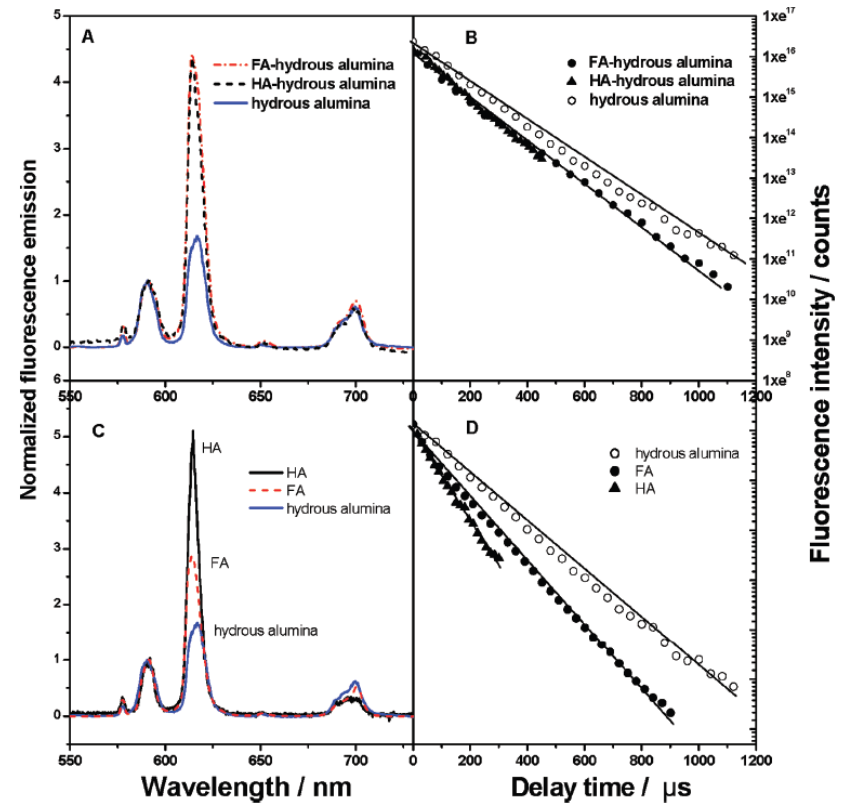
Figure 4. TRLFS results for Eu(III) bound to HA, FA, hydrous alumina, HA-hydrous alumina, and FA-hydrous alumina hybrids. C(hydrous alumina) = 4.4 g/L, = 4.3  10 -5 mol/L, C(FA/HA) C(Eu(III)) (initial) pH = 6.3 ± 0.1, T = 20 ± 1 ºC